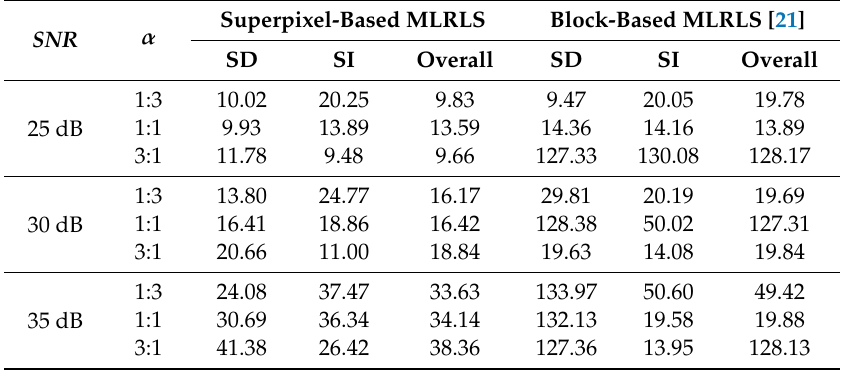
Table 5. The computational time of the superpixel-based MLRLS and the block-based MLRLS (unit: